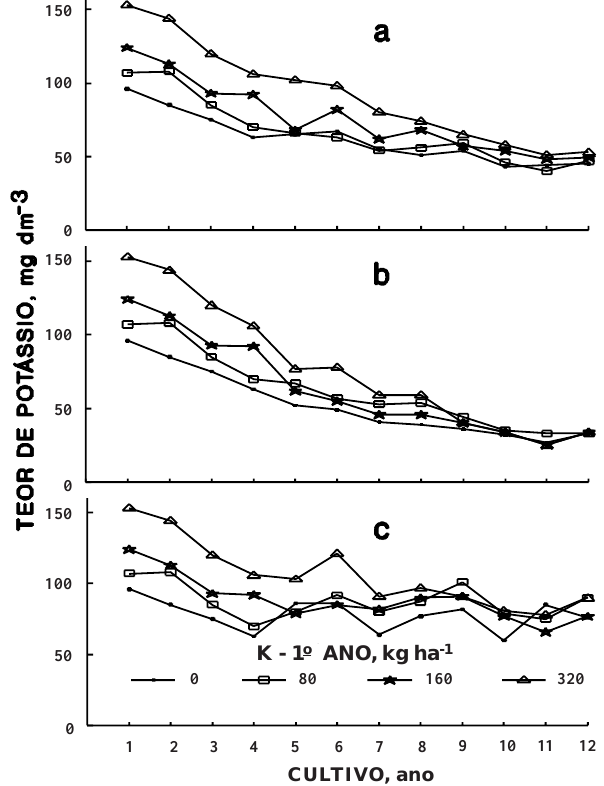
Figura 4. Teor de potássio disponível no solo em função das doses de adubo aplicadas, no primeiro ano, nas parcelas (0, 80, 160 e 320 kg ha -1 de K 2 O), e, anualmente, (a: 0, b: 40 e c: 80 kg ha -1 de K 2 O), a partir do quinto ano, nas subparcelas. Média de três repetições.